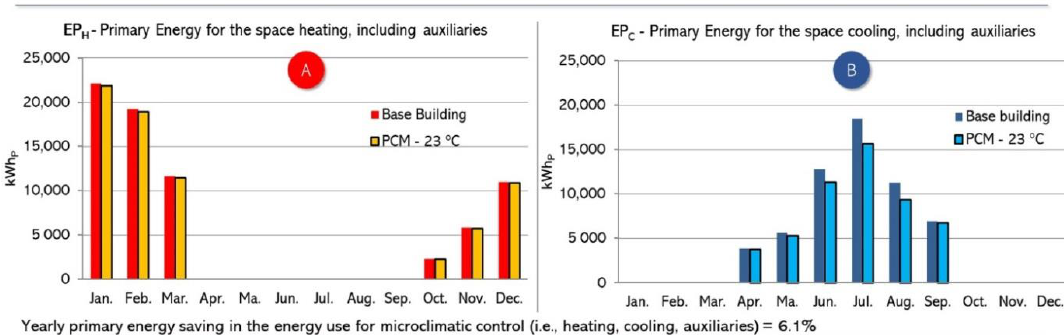
Figure 14. HVAC Heating and cooling primary energy demand, before and after the PCM